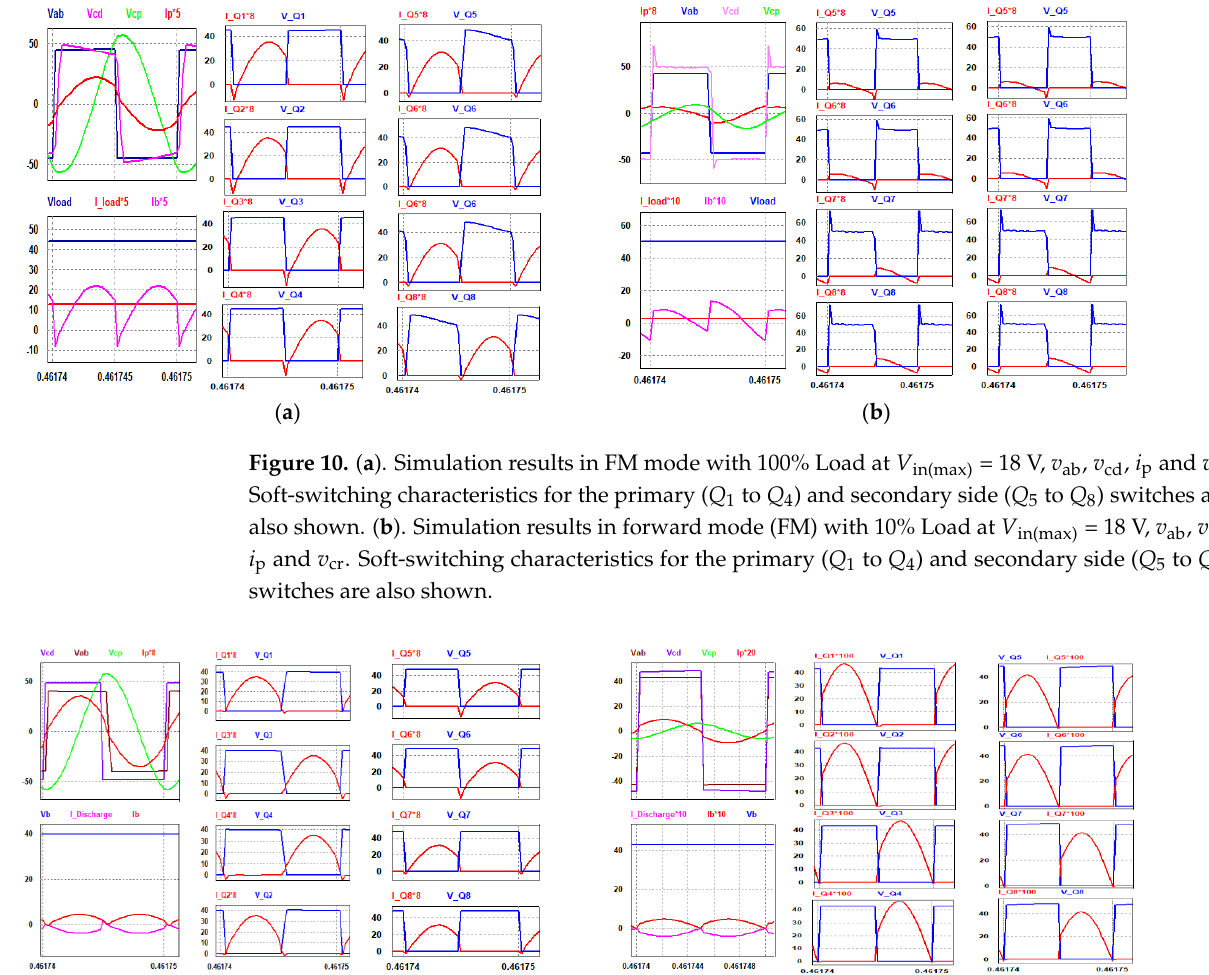
Figure 9. ( a ). Simulation results in FM mode with 100% Load at V in(min) = 12 V, v ab , v cd , i p and v cr . Soft- switching characteristics for the primary ( Q 1 to Q 4 ) and secondary side ( Q 5 to Q 8 ) switches are also shown. ( b ). Simulation results in FM mode with 10% Load at V in(min) = 12 V, v ab , v cd , i p and v cr . Soft- switching characteristics for the primary ( Q 1 to Q 4 ) and secondary side ( Q 5 to Q 8 ) switches are also shown.